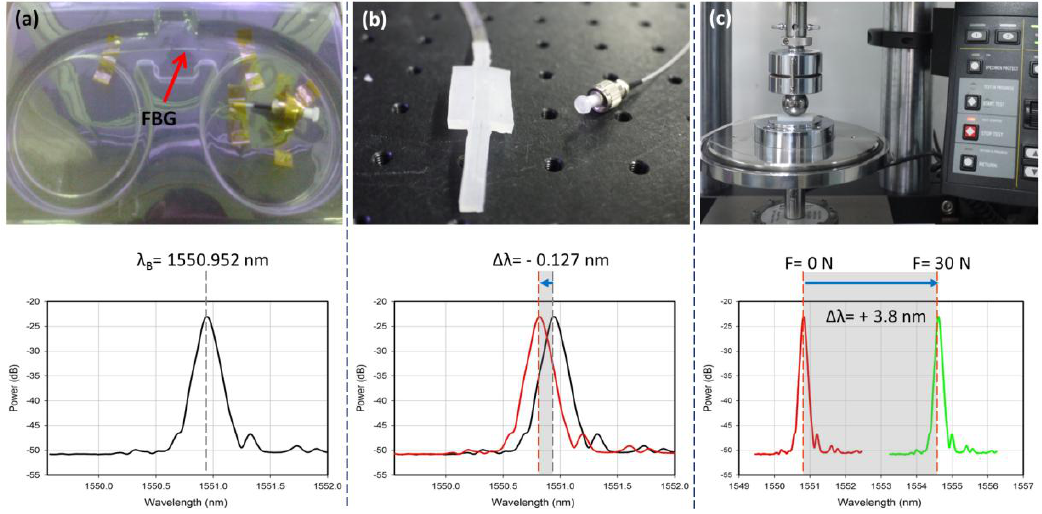
Figure 6. ( a ) Bare FBG spectrum. ( b ) Packaged FBG spectrum (red line) compared to the bare FBG and ( c ) Indication of the minimum (red)/maximum (green) shifts caused by the minimum/maximum applied forces during